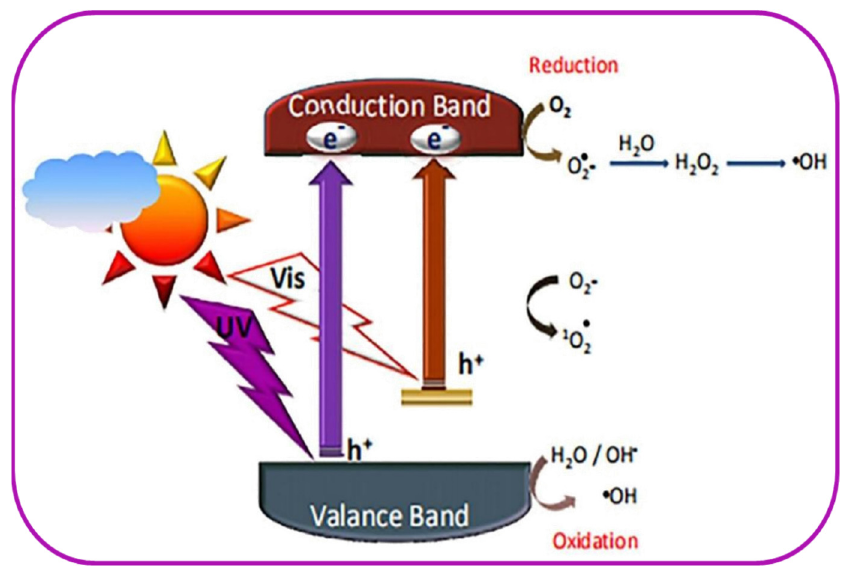
Figure 3. Schematic photocatalysis mechanism (https://pubs.acs.org/doi/10.1021/jz501030x, accessed on 3 November 2021) [149].